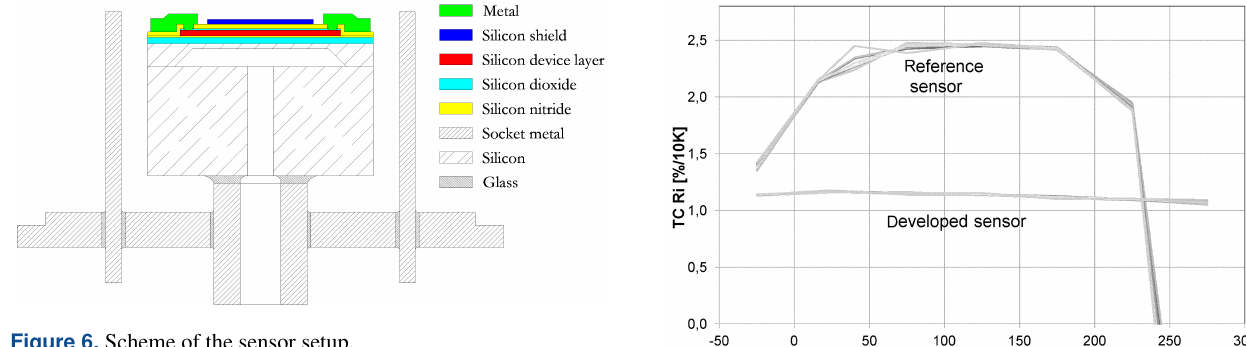
Figure 6. Scheme of the sensor setup.